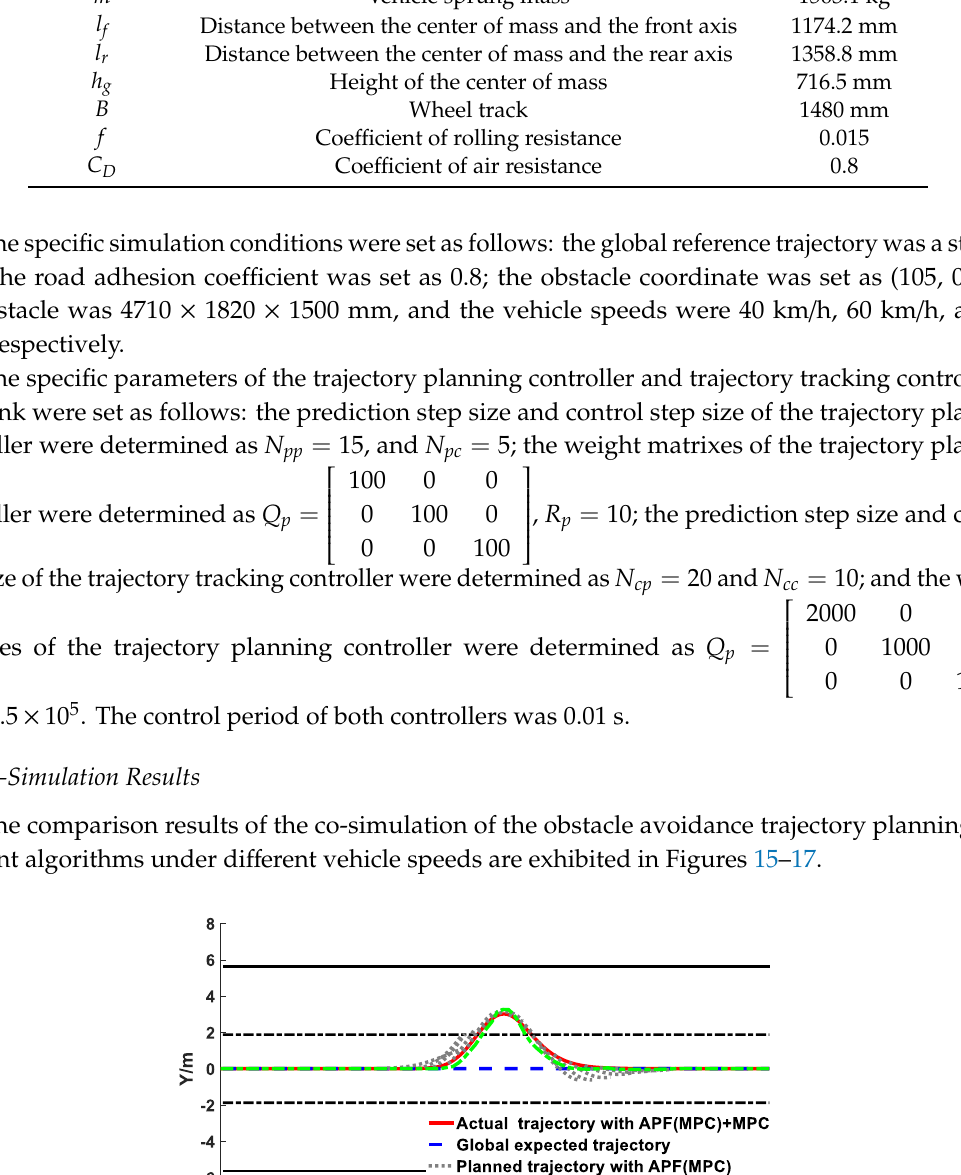
Figure 16. Co-simulation results of obstacle avoidance trajectory planning under 60 km/h. Figure 17. Co-simulation results of obstacle avoidance trajectory planning under 80 km/h. It can be observed from Figures 15 – 17 that under different vehicle speeds, the obstacle avoidance controllers based on the APF with MPC model derived from previous study [41] and the APF(MPC) with MPC model proposed in this study can effectively plan and track the local obstacle avoidance trajectory that satisfies the obstacle and road boundary constraints in real time in the predicted time domain, and the trajectory tracking controllers based on the linear time-varying MPC algorithm can promptly and accurately track the first two reference points of the local